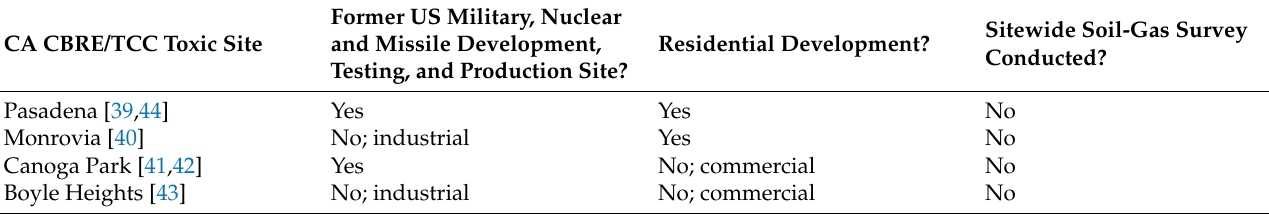
Table 7. Redevelopment toxic sites with trichloroethylene (TCE) and other volatile-organic-compound (VOC)